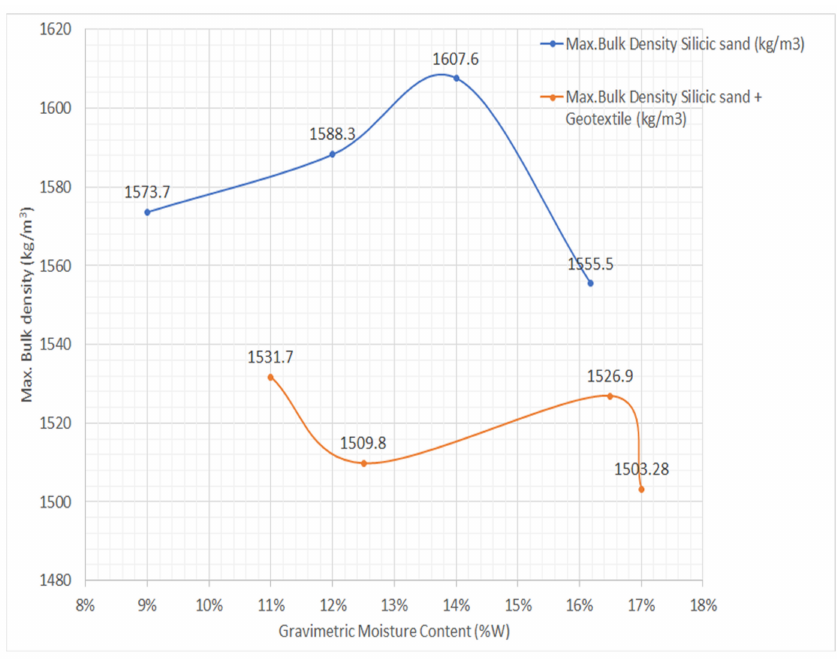
Figure A1. Bulk density of silicic sand and silicic sand and geotextile addition with gravimetric moisture content (kg/m 3 ).